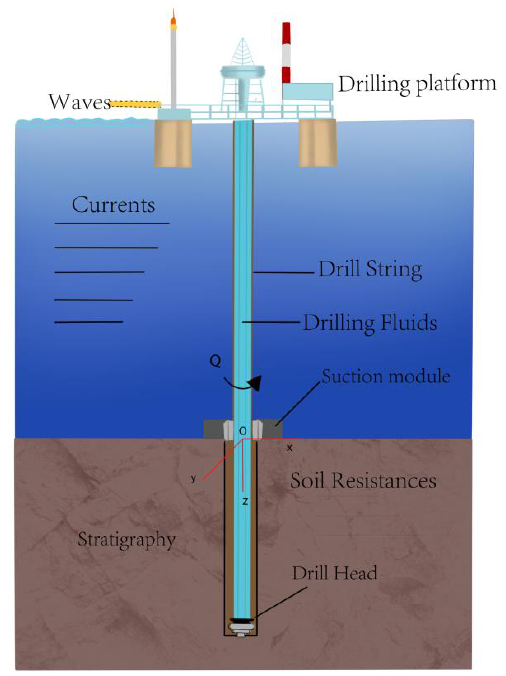
Figure 2. Overall force state diagram.